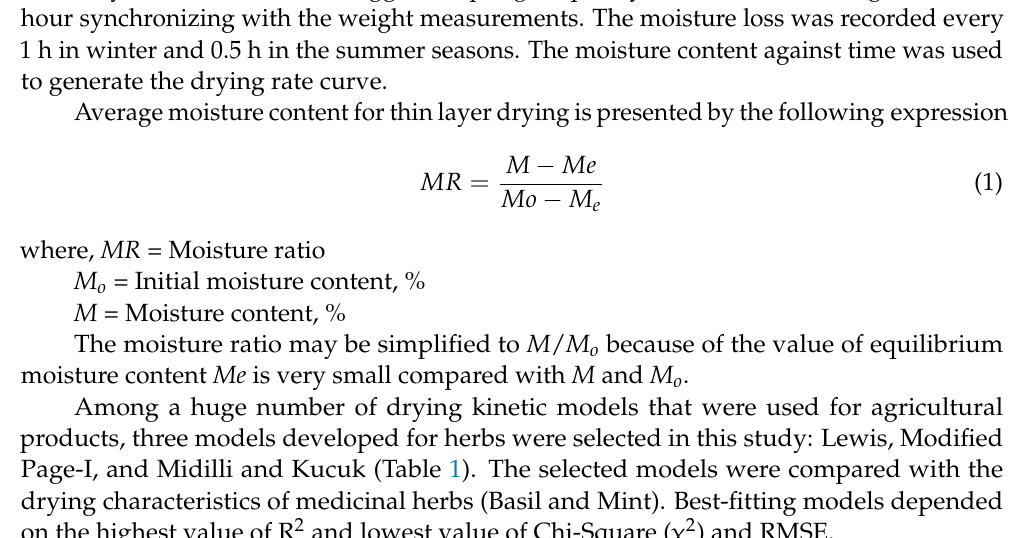
Table 1. Mathematical models used to describe the drying kinetics of leafy